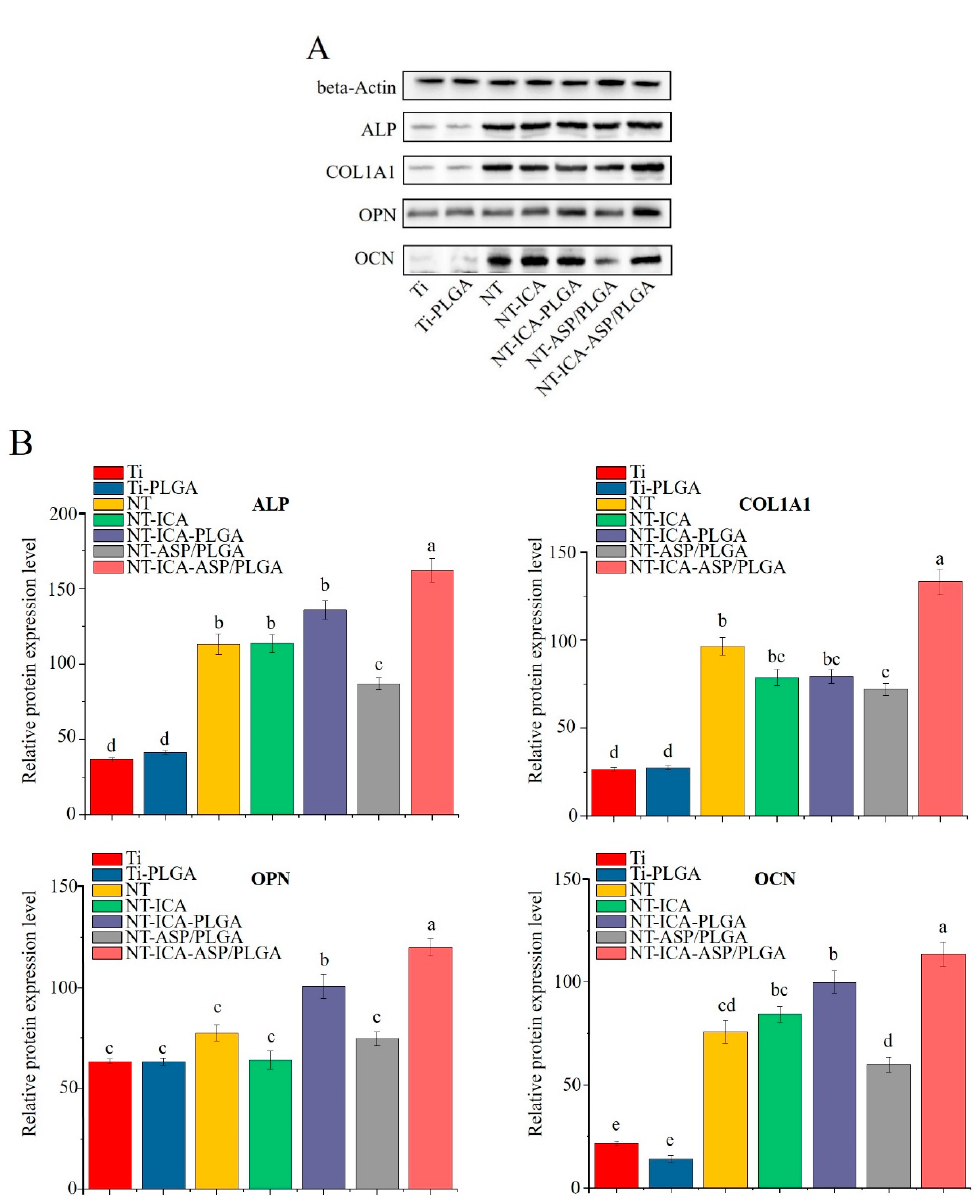
Figure 12. ( A ) Western blot showing the protein expression levels of ALP, COL1A1, OPN and OCN and beta-Actin in MC3T3-E1 cells after 14 days of culture on different samples. ( B ) The corresponding gray-scale values of proteins levels in the 7 groups. Different lowercase letters indicate statistically significant differences between different groups ( p < 0.05). Data are mean ± SD, n = 3 replicates each group.